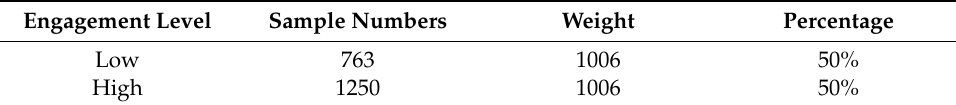
Table 4. Sample statistics of engagement level after using balancing filter.